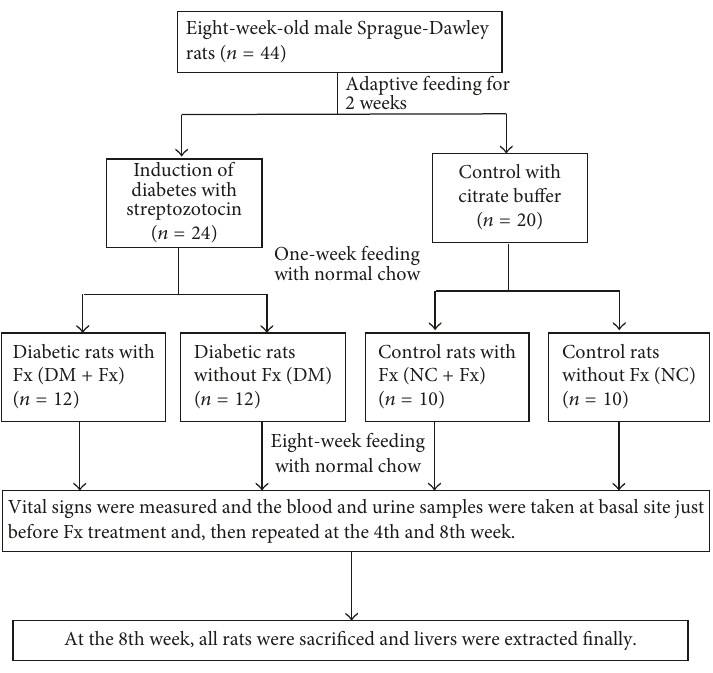
Figure 1: Schematic diagram of the animal experiment protocol. Fx: febuxostat. NC: the normal control group without Fx treatment; NC + Fx: the normal group with Fx treatment; DM: diabetic mellitus group without Fx treatment; DM + Fx: diabetic mellitus group with Fx